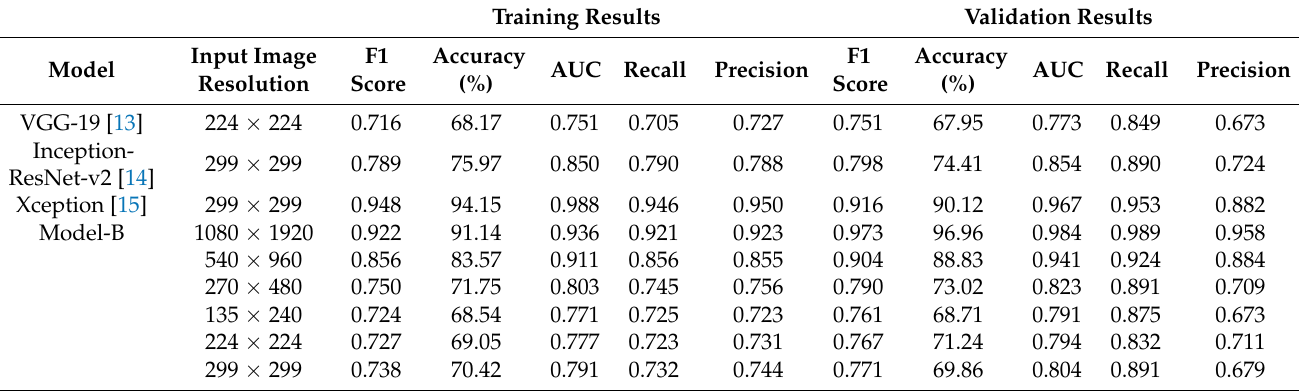
Table 4. Accuracy, recall, precision, AUC obtained with train and validation data (DFDC sample).